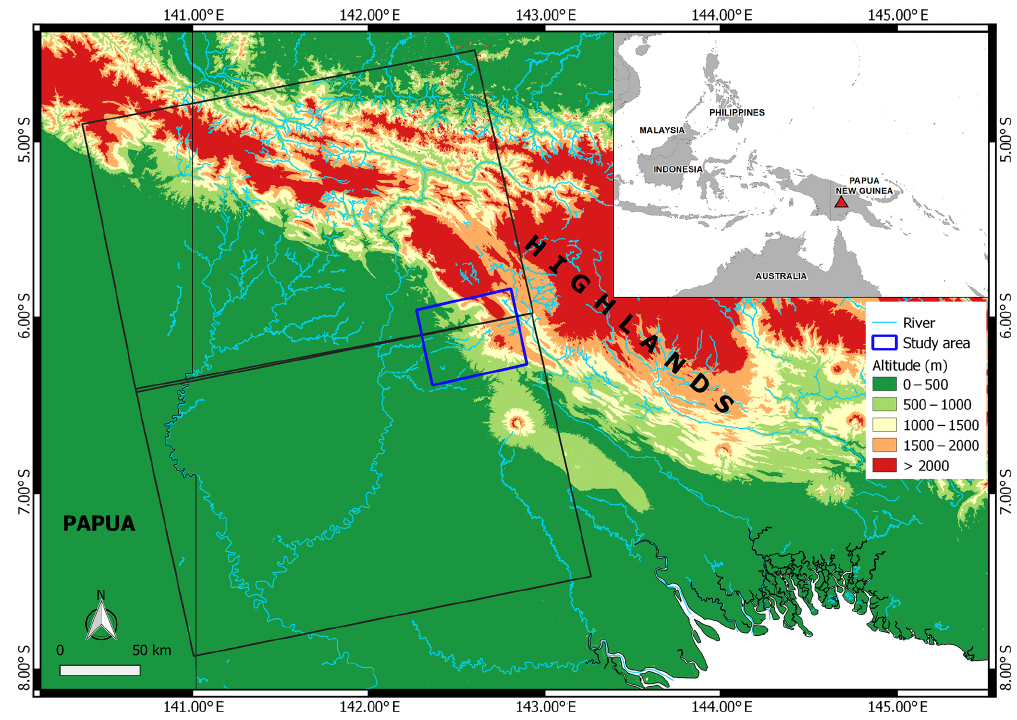
Figure 2. Location of the test site. The area of interest (AoI) is highlighted with a blue rectangle on the main map and with a red triangle in the inset. The black rectangles show the spatial coverage of the used Sentinel-1 SAR